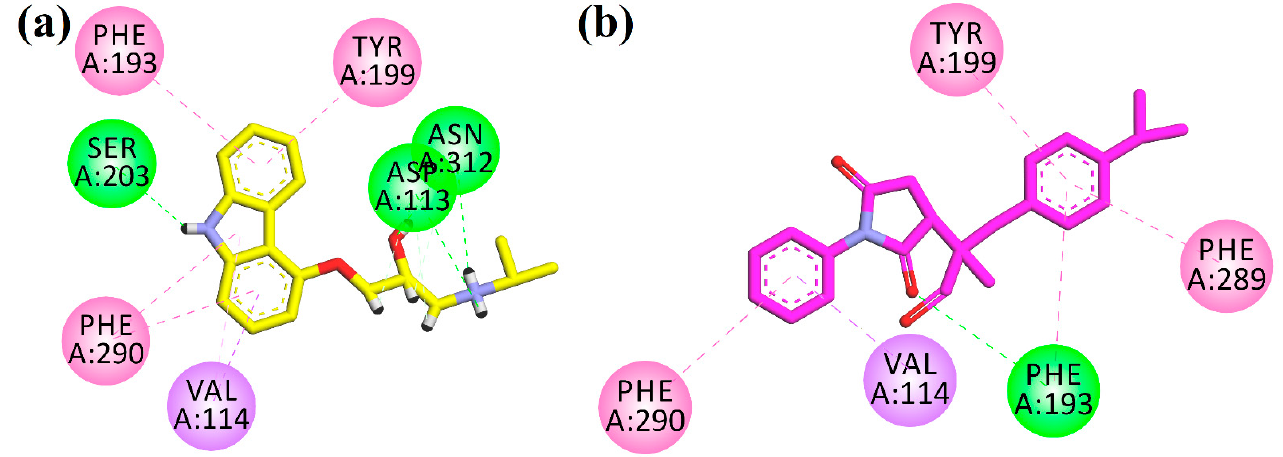
Figure 6. The 2D interaction plot of ( a ) native compound (yellow stick model) and ( b ) Compound R,S-1 (pink stick model) in the binding site of human beta2-adrenergic G protein-coupled receptor.